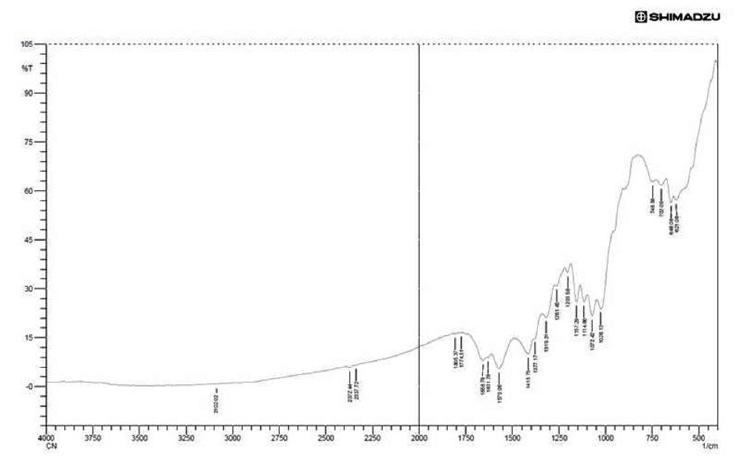
Fig. 7. FTIR analysis of chitin